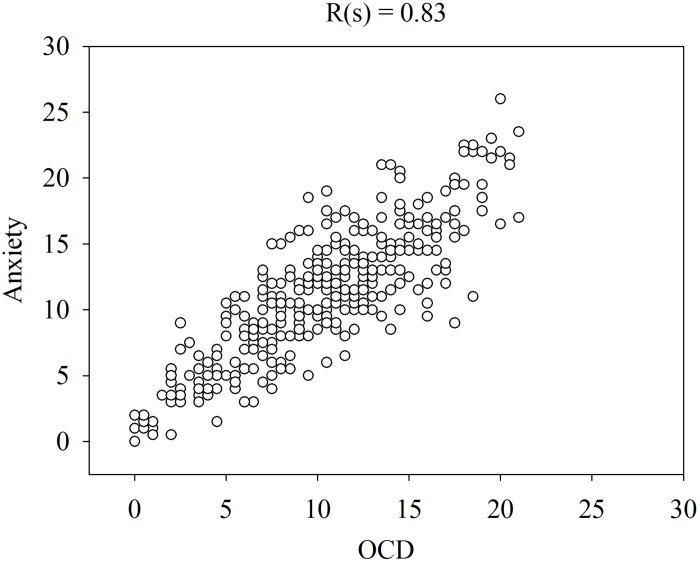
Spearman rank correlation [R(s)] among anxiety and OCD in 358 patients with anorexia nervosa determined with the CPRS.